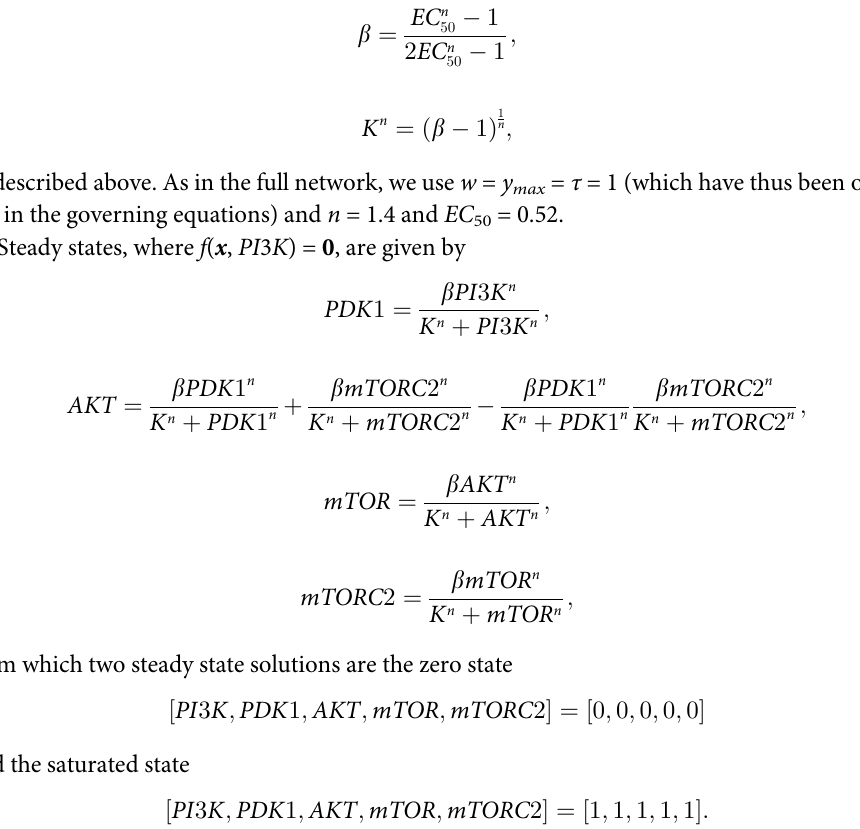
S1 Fig. Schematic rendering of the smooth muscle cell network model (cf. Fig 1, main text), but with an emphasis on the embedded PI3K/AKT/mTOR signaling pathway. The solid ellipse highlights the TSC1/2 node, which we used to simulate Tsc1 knock-out by setting its y = 0. The dashed ellipse highlights the mTORC1 node, which is the primary target of max the inhibitor rapamycin. We simulated full inhibition by rapamycin by setting y mTORC1 node. See Table A in S1 Text and the associated 105 references that were used